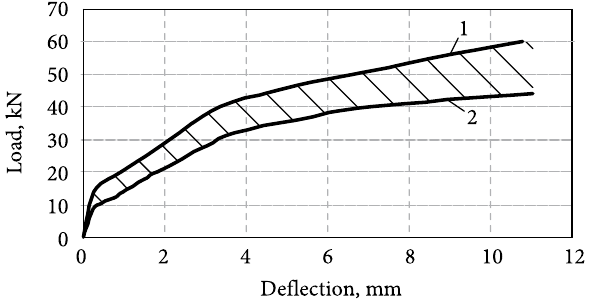
Fig. 10. Load-deflection relationship for beam SA6–1 with best anchorage (1) and for beam SB6–1 with worst anchorage (2)